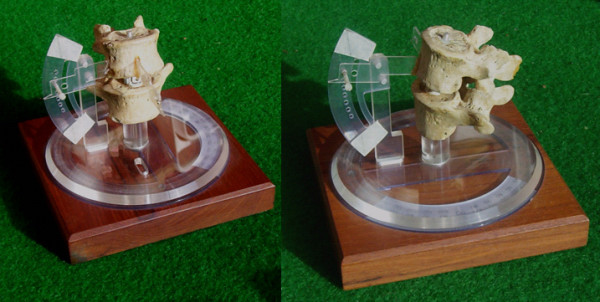
Calibration model 1. with inter-body universal joint and calibrated protractors for intervertebral angle and whole model rotational settings